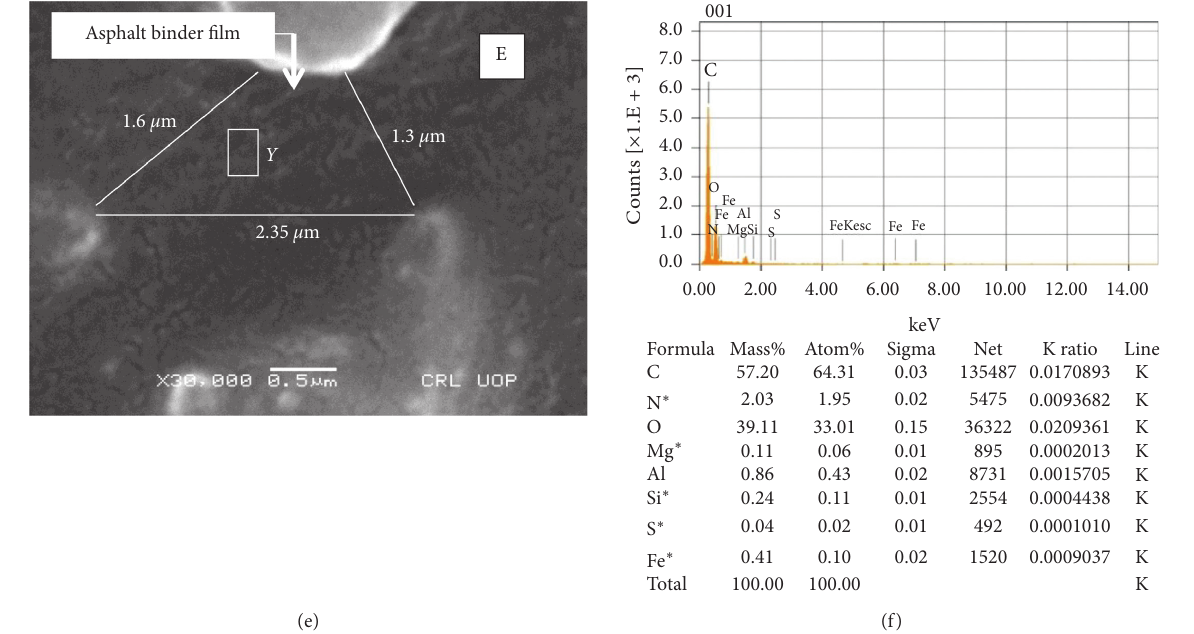
Figure 9: SEM images of HMA at 150 ° C and optimized binder content of 4.23%: (a) asphalt mortar at magnification × 250 and bar scale 100 μ m. (b) Asphalt mortar at magnification × 300 and bar scale 50 μ m. (c) Filler particles at magnification × 5000 and bar scale 5 μ